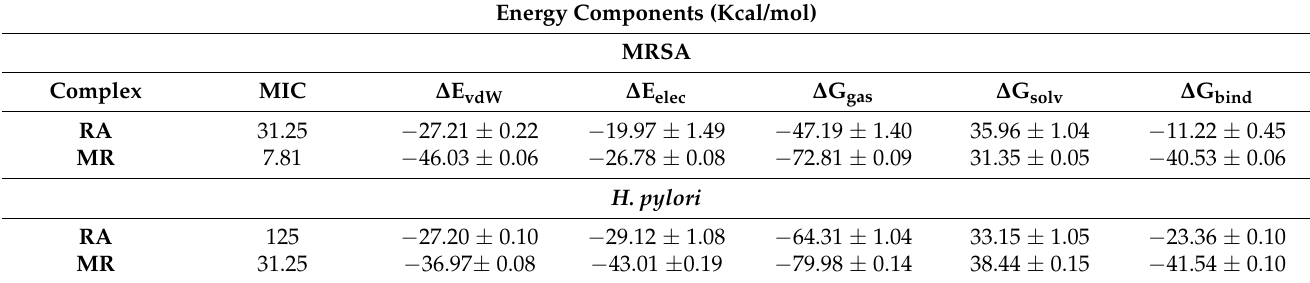
Table 3. Summary of the energy binding calculated for methyl rosmarinate (MR) and rosmarinic